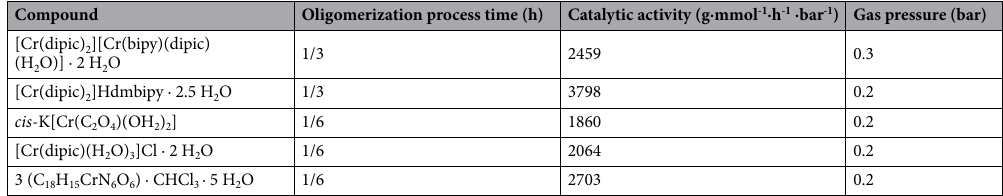
Table 1. Data for the ethylene oligomerization catalyzed by chromium(III)-based complexes.